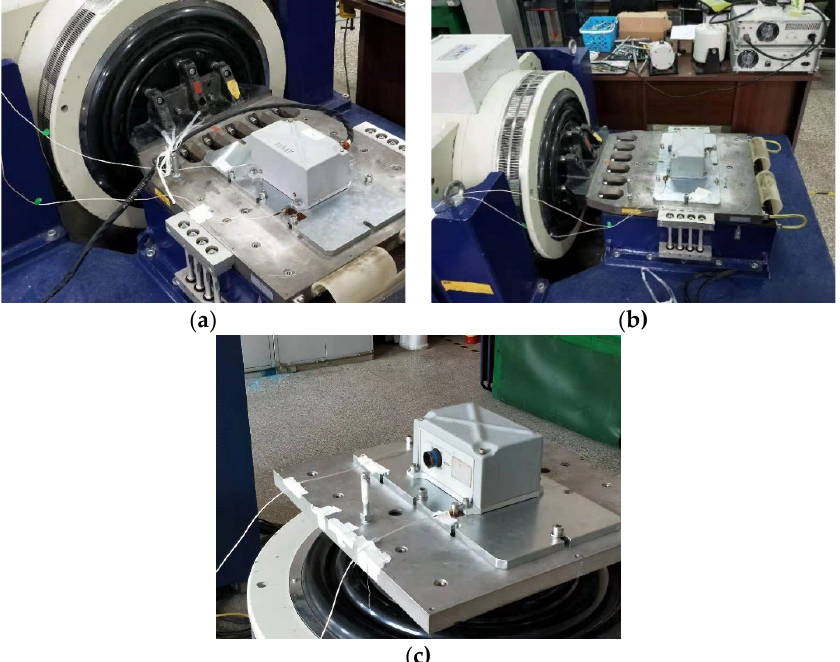
Figure 14. Installation direction of the electrical control box on the test bench: ( a ) X direction; ( b ) Y direction; ( c ) Z